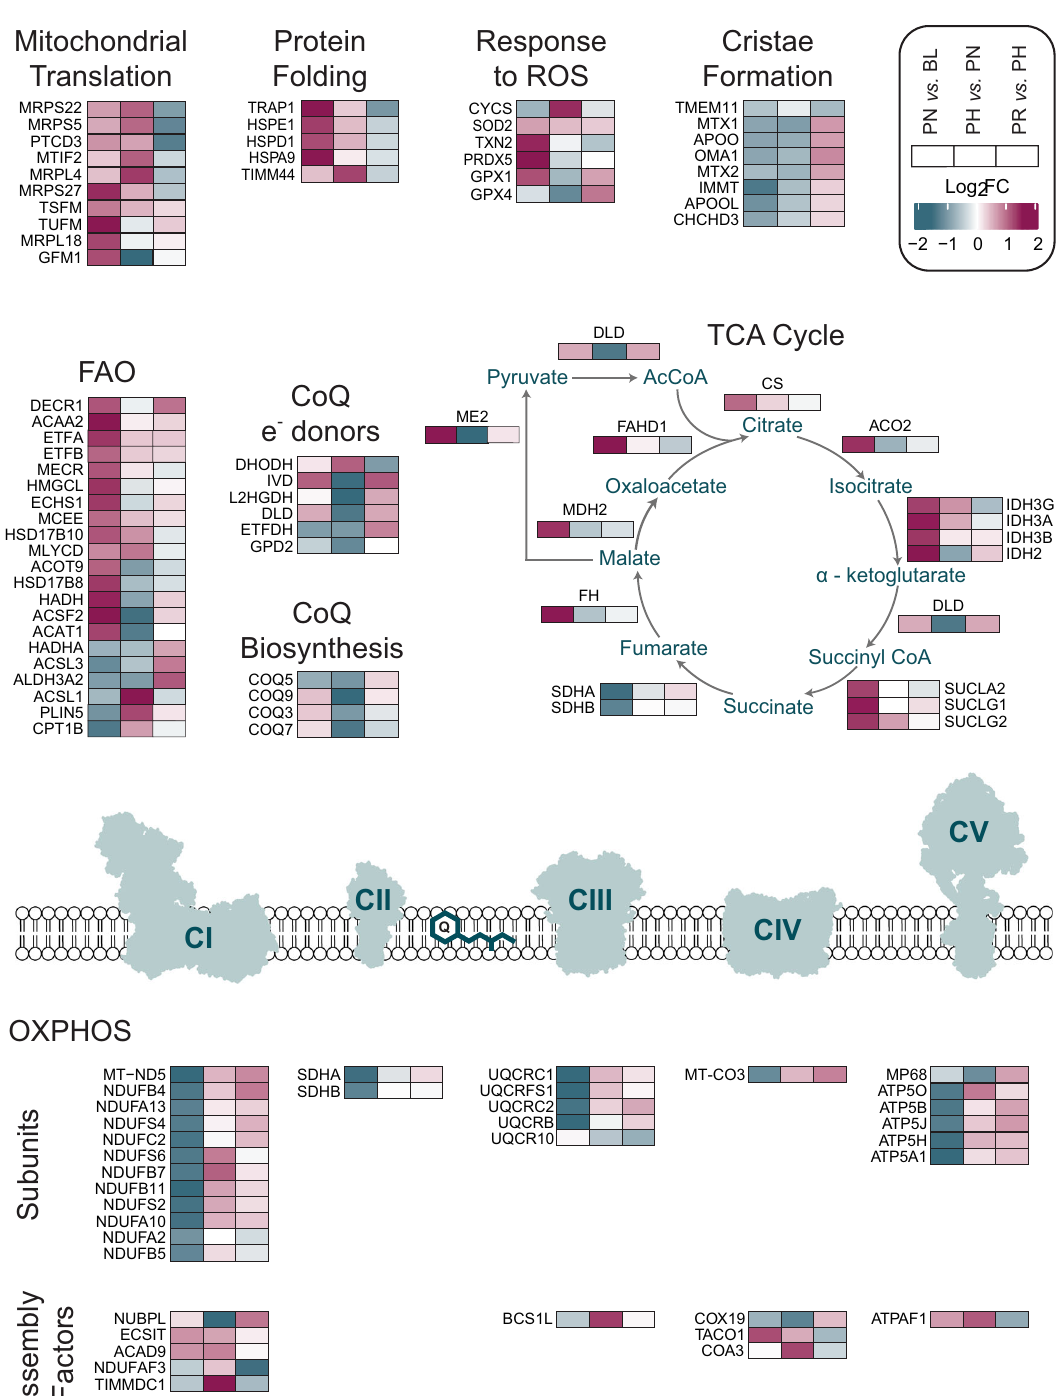
Fig. 3 Overview of training-induced changes in mitochondrial protein functional classes and metabolic pathways. Protein functional classes and/or metabolic pathways (de fi ned in Supplementary Data 6) as determined in Supplementary Data 7. Row clustering determined by unsupervised hierarchical cluster analysis. BL baseline, PN post-NVT, PH post-HVT, PR post-RVT, ROS reactive oxygen species, FAO fatty acid β -oxidation, CoQ Coenzyme Q, TCA tricarboxylic acid cycle, OXPHOS oxidative